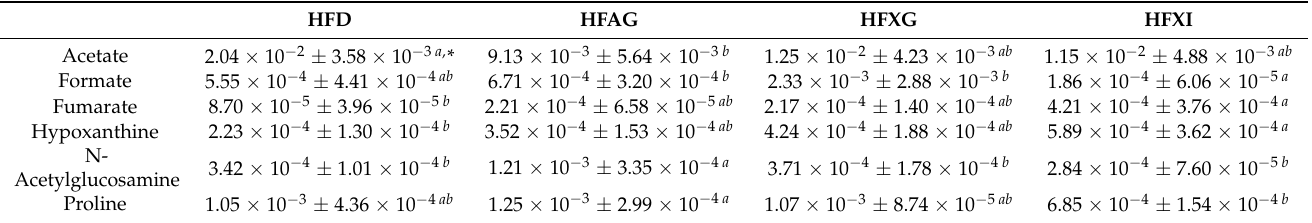
Table 4. Molecules with significant differences in cecum contents of HFD, HFAG, HFAXG, and HFXI groups.